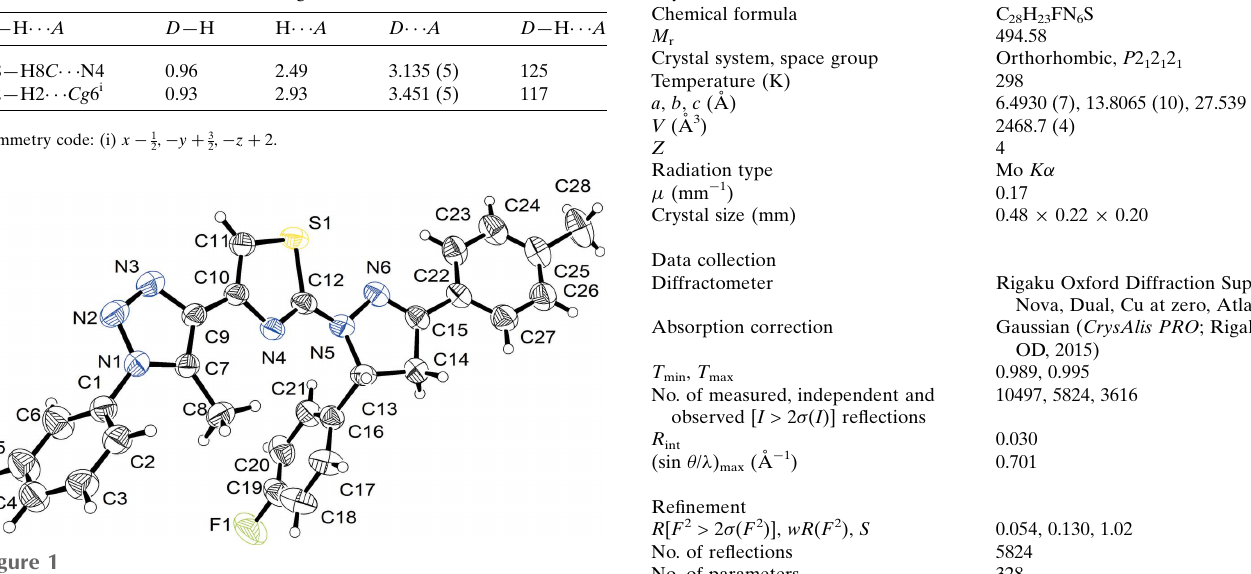
Table 1 Hydrogen-bond geometry (A˚ , (cid:2) ). Cg 6 is the centroid of the C22–C27 ring.